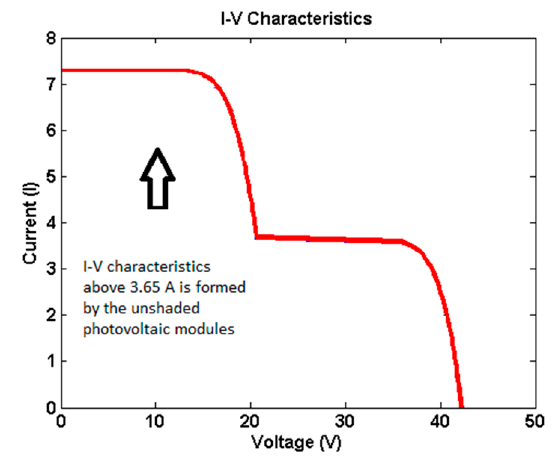
Figure 16. I-V characteristics above 3.65 A—formed by unshaded modules.